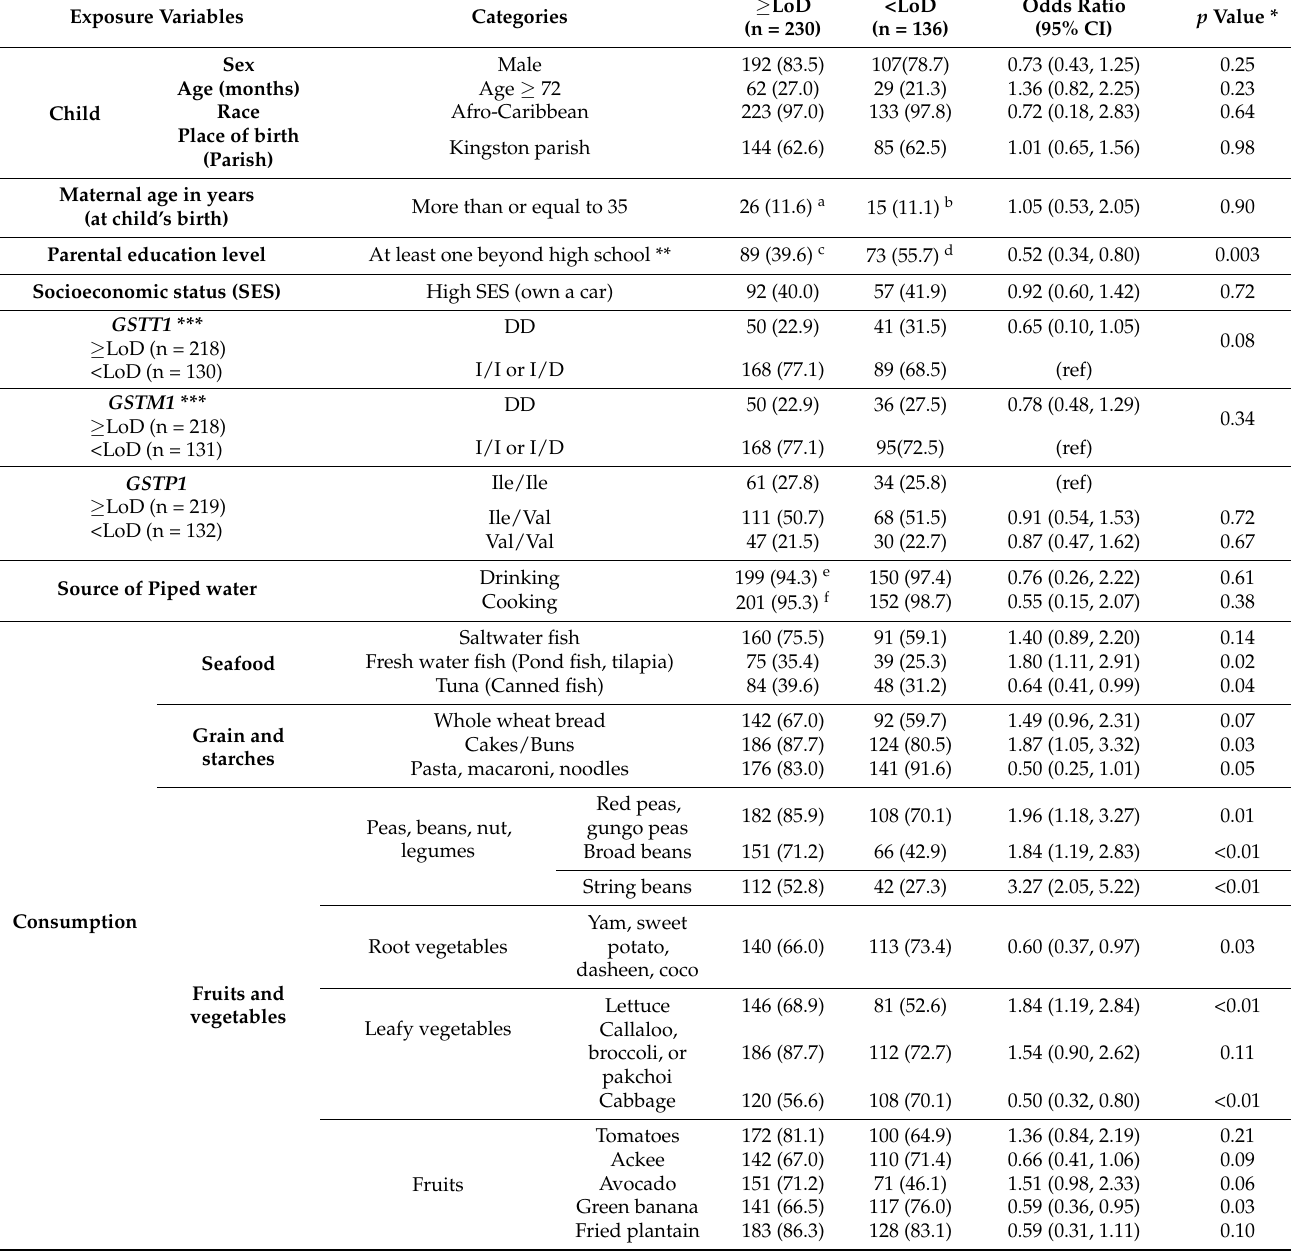
Table 2. Univariable associations of environmental factors and genotypes for GST genes with detectable blood Al concentrations (BAlCs) in typically developing (TD) children (N =